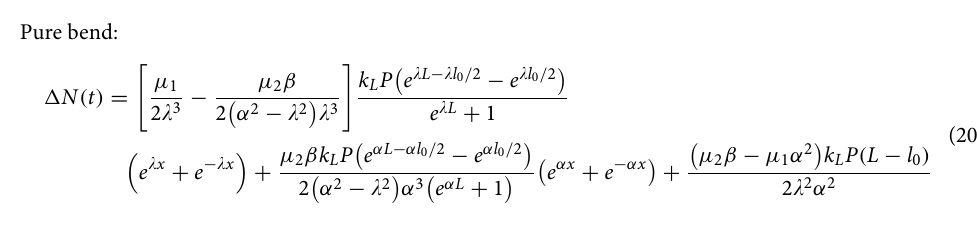
Figure 5. Coupling influence of stiffness under creep on axial force